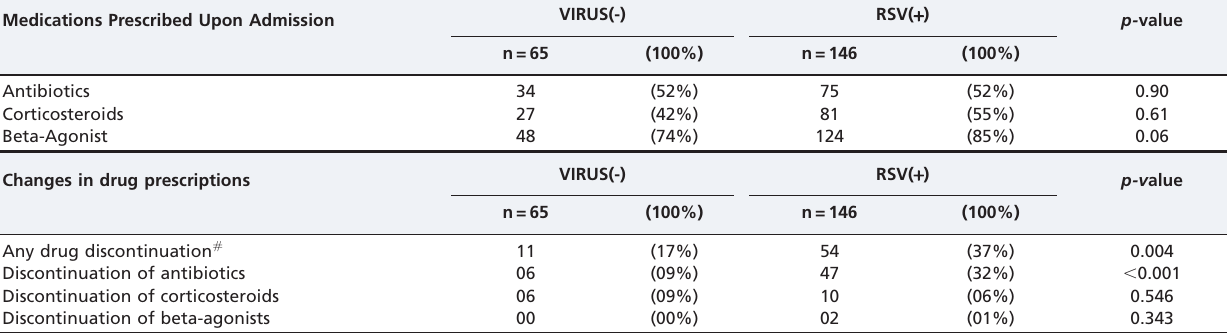
Table 2 - Medications prescribed upon admission to the hospital and drug discontinuation after virus screening for patients in the VIRUS(-) and RSV( + ) groups.